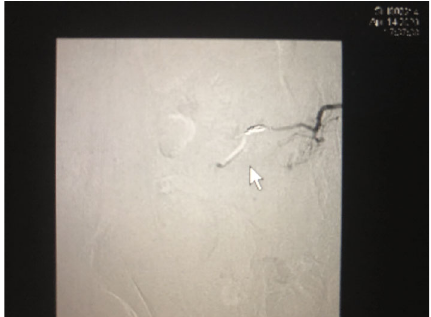
Figure 4: CT scan of the abdomen and pelvis for the second patient; the white arrow points towards a site of active extravasation ( “ blush ” ).